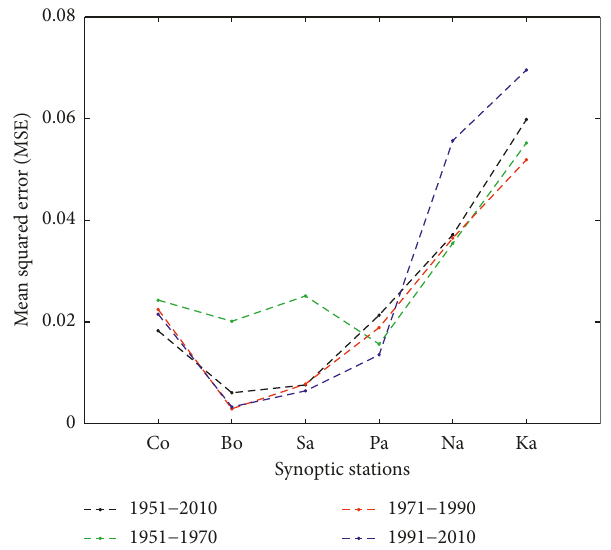
Figure 8: Spatiotemporal variation of the mean squared error